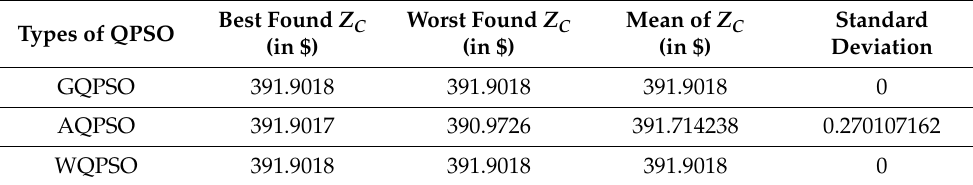
Table 10. Statistical Analysis for different variants of QPSO for Case-III of Example 3. Types of